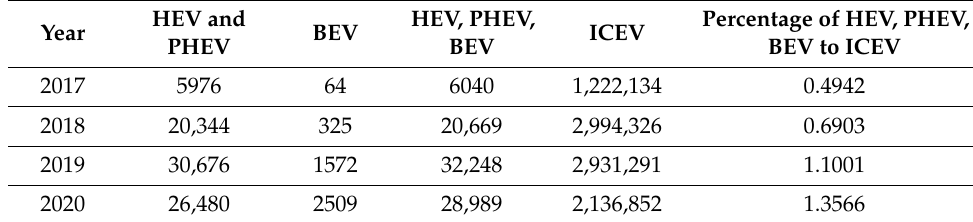
Table 2. Number of HEVs and PHEVs, BEVs, ICEVs in Thailand from